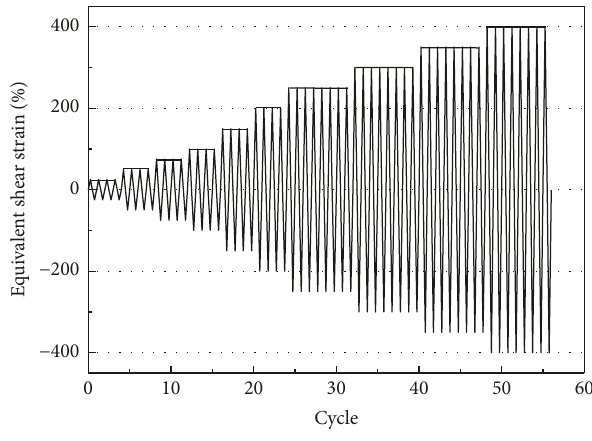
Figure 4: Cyclic testing